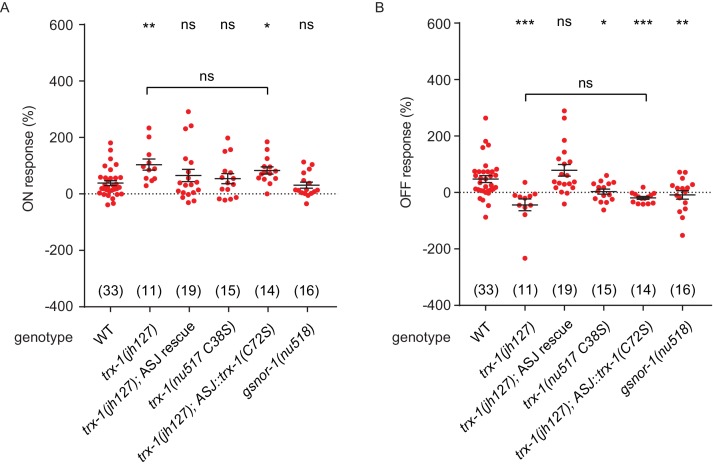
NO response amplitudes for data in Figure 7.(A, B) NO evoked ON (A) and OFF (B) response amplitudes (scatter plots and mean ± SEM) are shown for recordings in Figure 7. ON and OFF response amplitudes are defined in the Methods. For statistical analysis, responses of all mutant genotypes in Figures 4–7 were compared with a common set of wild type controls using Kruskal–Wallis one-way analysis of variance. Significant differences from wild type are indicated as follows: *p<0.05; **p<0.01; ***p<0.001; ns, not significant. The number of animals analyzed is indicated for each genotype.